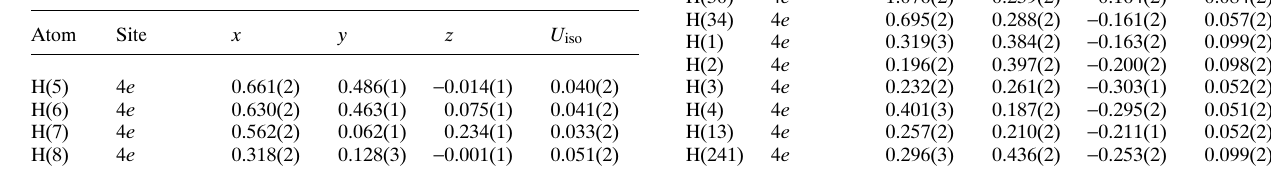
Table 2. Atomic coordinates and displacement parameters (in Å 2 ) .